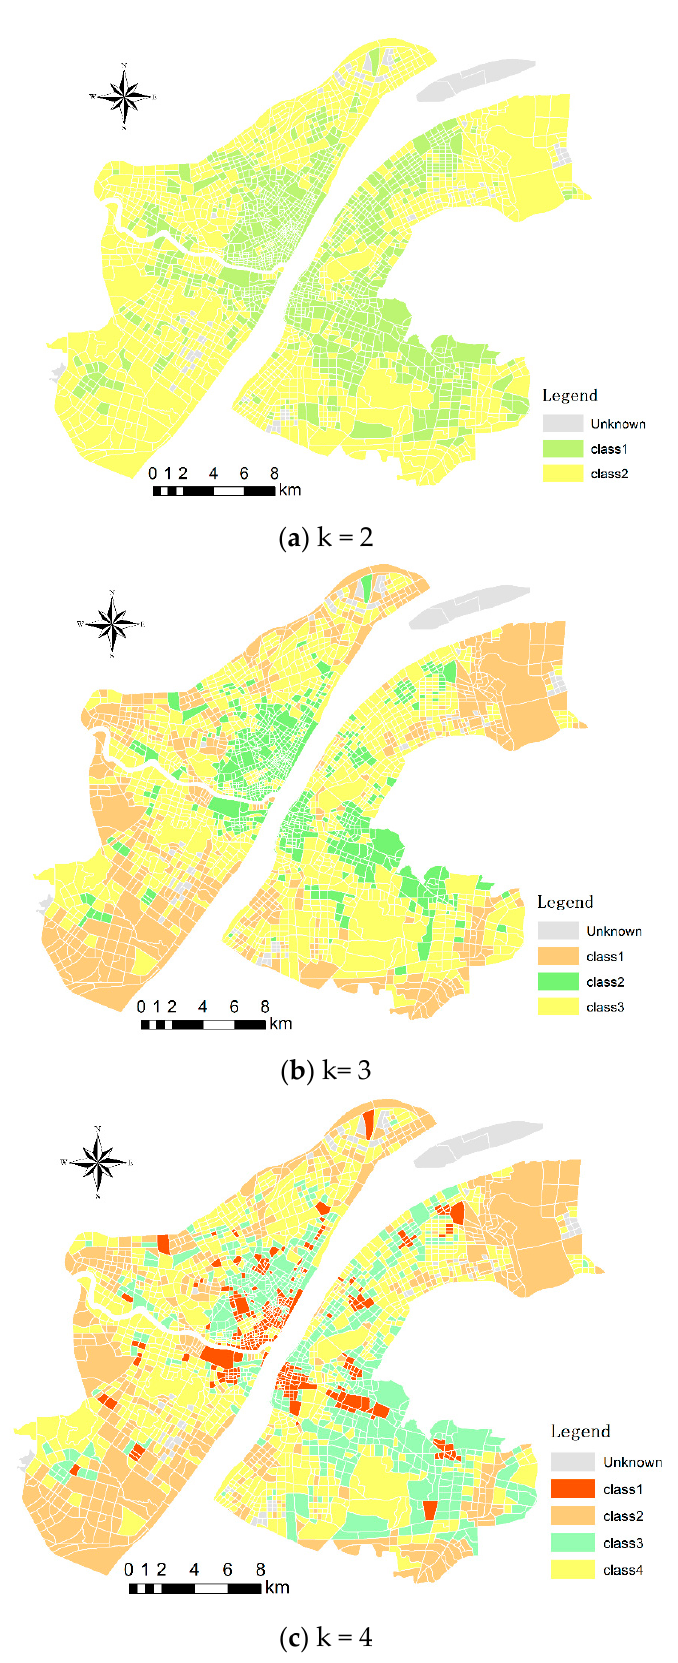
Figure 8. Results of K-Means clustering analysis of blocks using POI latent semantic features (k =